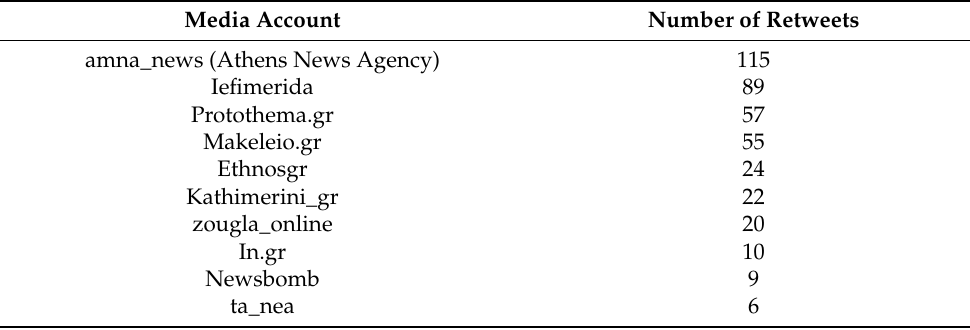
Table 6. Official media accounts by number of